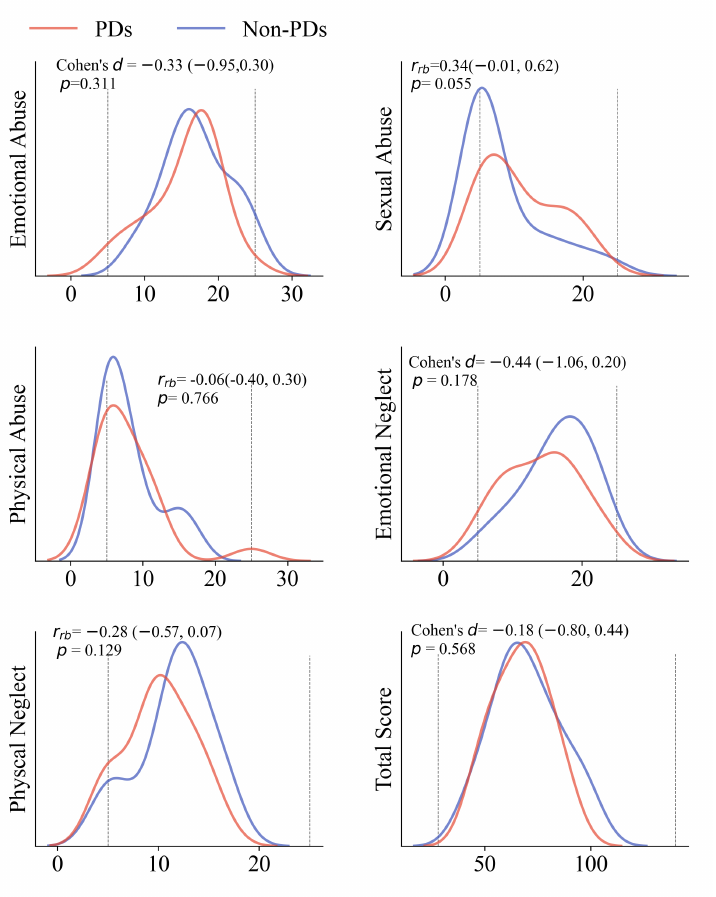
Figure 2. The kernel density estimation plots show the probability of the CTQ-SF scores in each group. Dashed lines show theoretical score ranges for each component. Effect sizes and p -values are reported in the